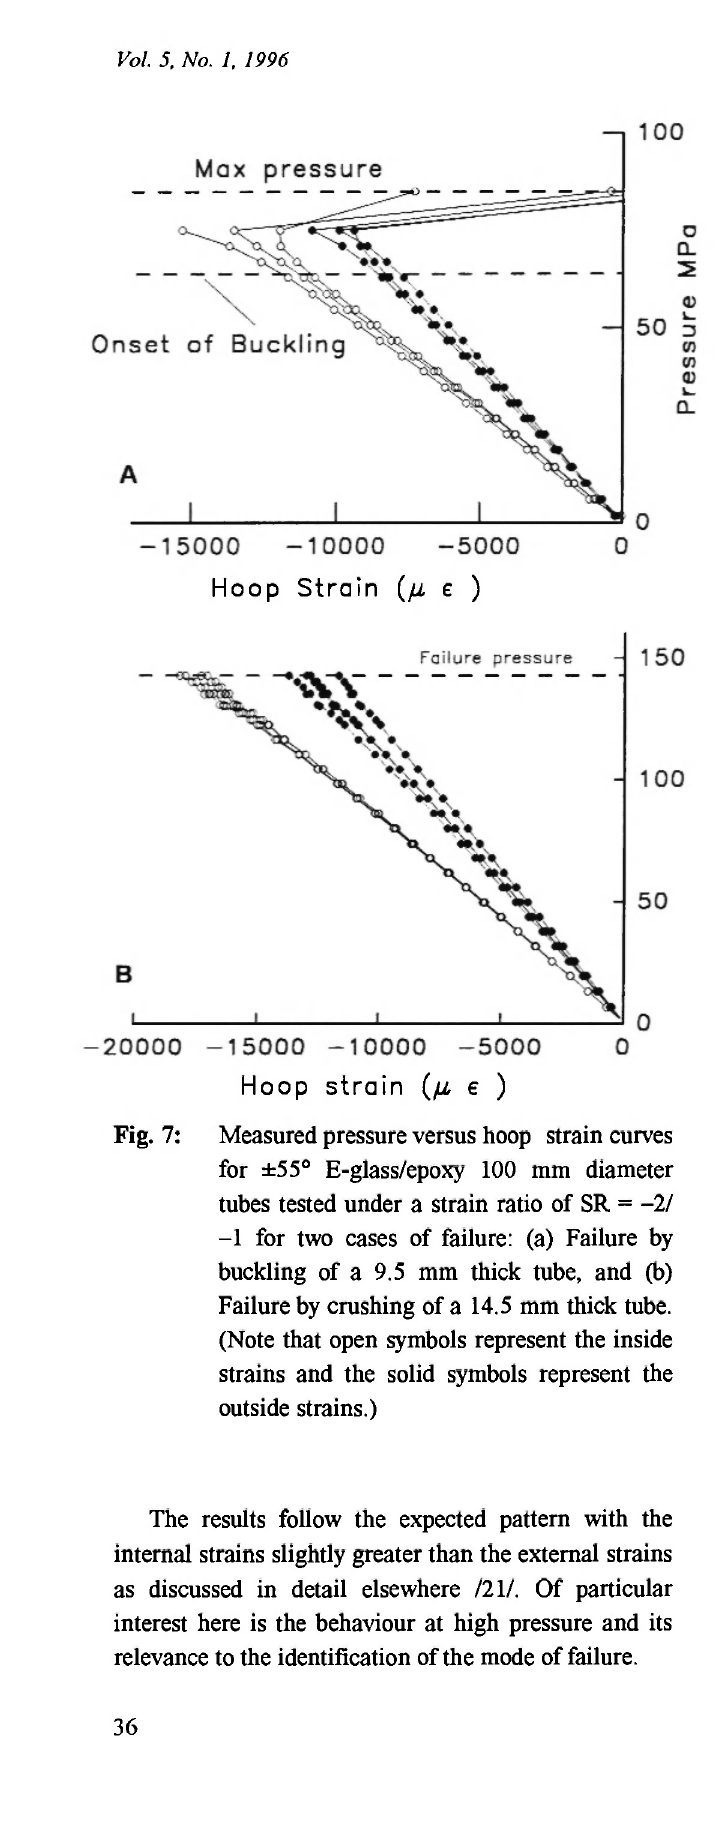
Fig. 7: Measured pressure versus hoop strain curves for ±55° E-glass/epoxy 100 mm diameter tubes tested under a strain ratio of SR = -2/ -1 for two cases of failure: (a) Failure by buckling of a 9.5 mm thick tube, and (b) Failure by crushing of a 14.5 mm thick tube. (Note that open symbols represent the inside strains and the solid symbols represent the outside